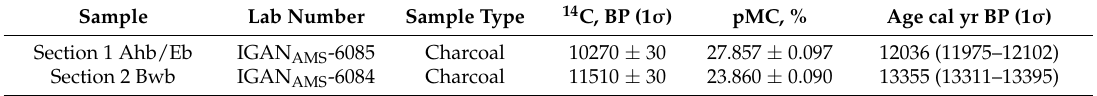
Table 3. The results of dating charcoals of